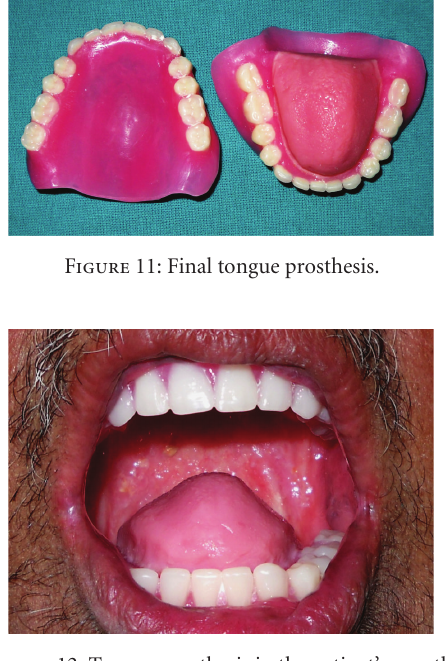
Figure 12: Tongue prosthesis in the patient’s mouth.